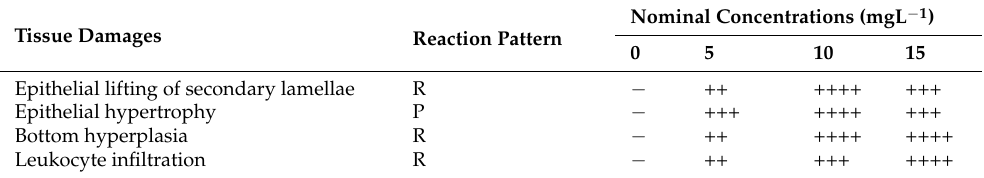
Table 4. Gills damages of Capoeta ( Capoeta capoeta ) 96 h after exposure to different levels of Ag-NPs.